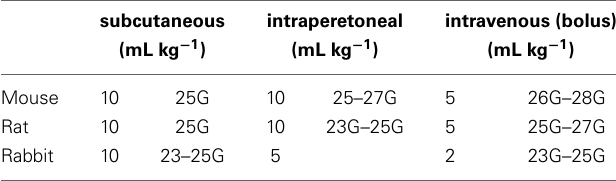
Table adapted from Diehl et al. [81] and from the German Society for Laboratory Animal Science (GV